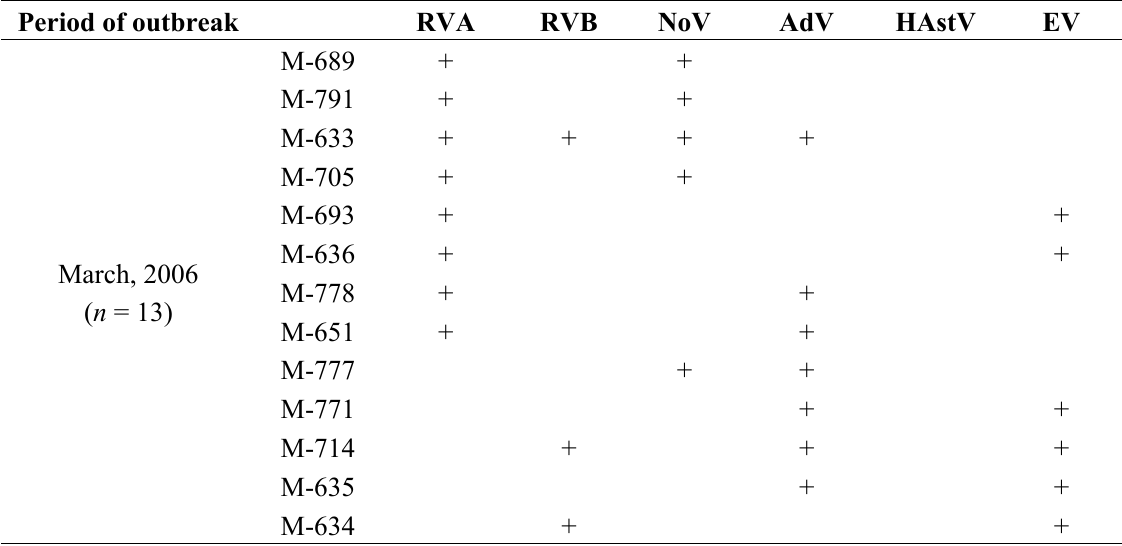
Table 2. Distribution of mixed enteric viruses detected in the outbreak cases of gastroenteritis. Period of